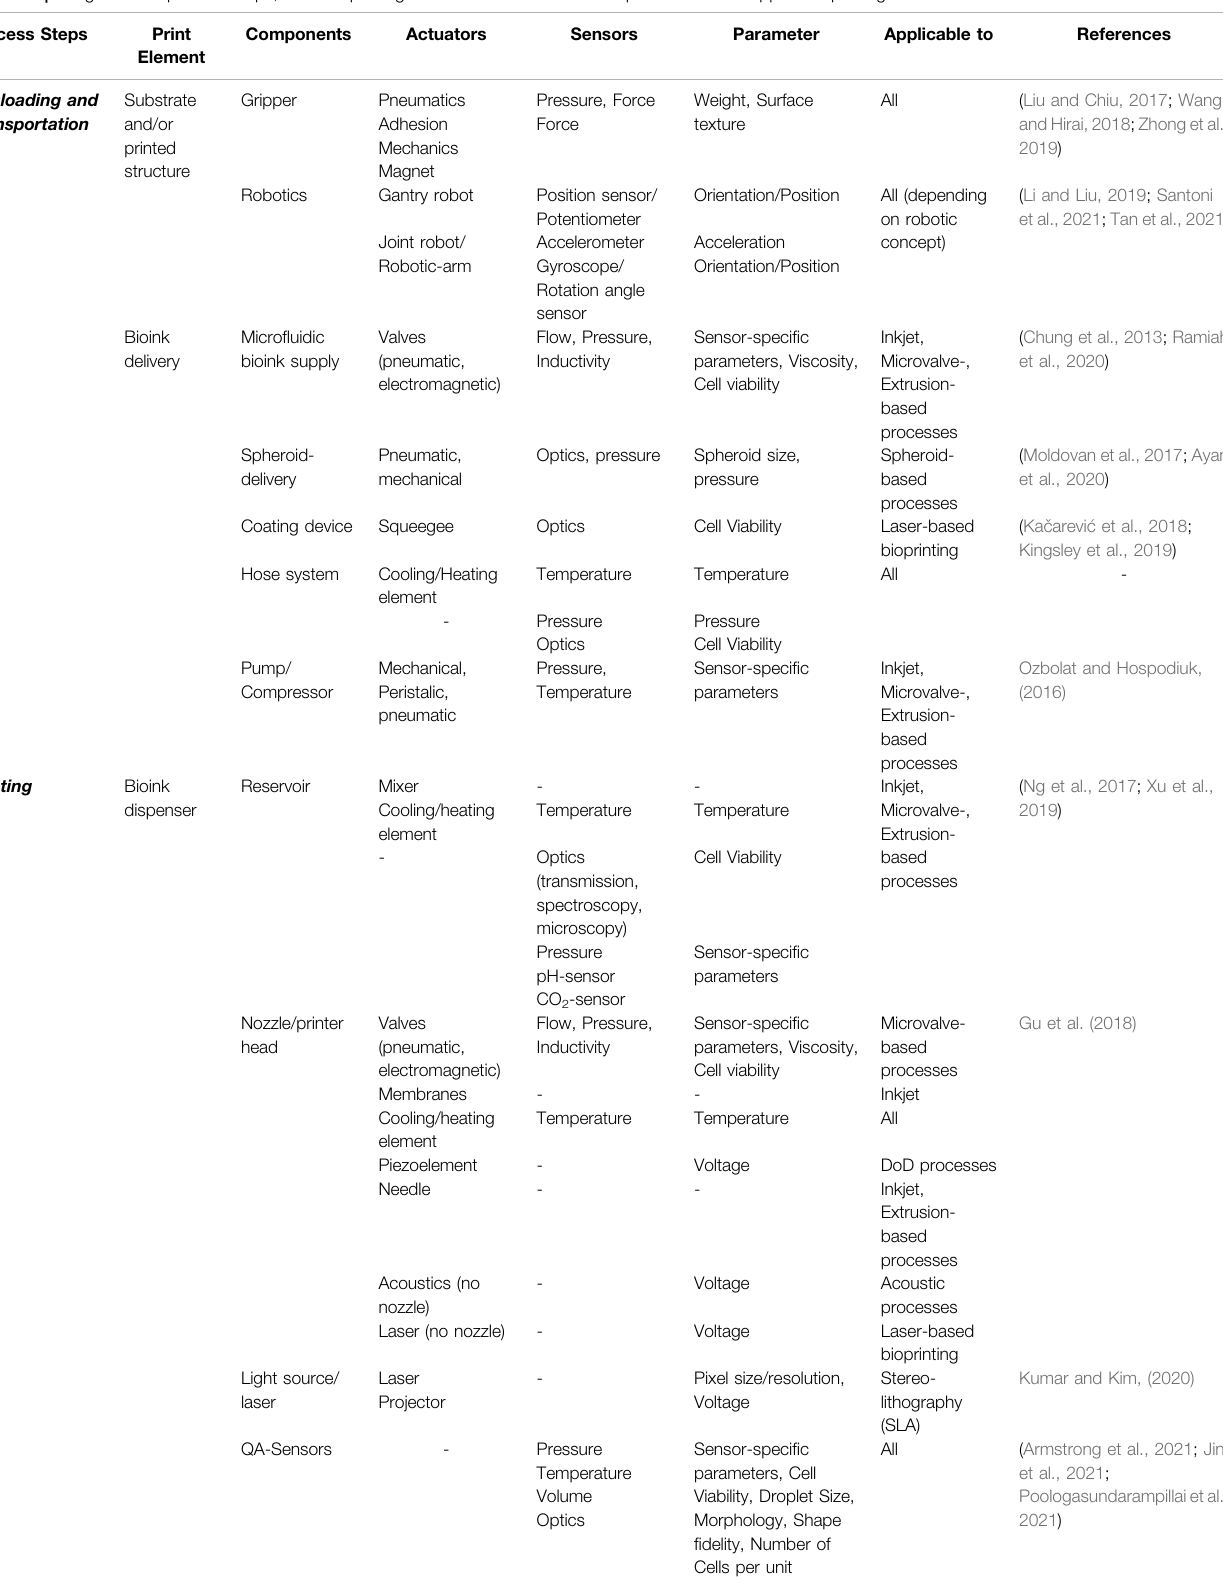
TABLE 1 | Assignment of process steps, involved printing elements and hardware components to their applicable printing